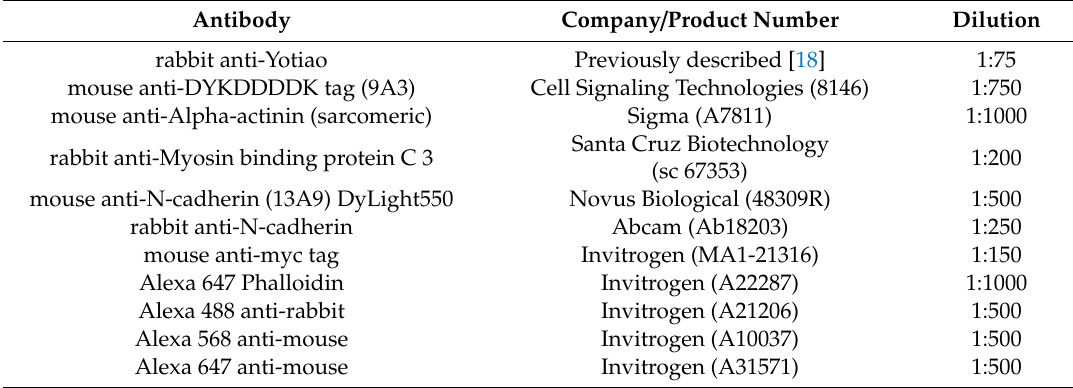
Table 1. Antibody dilutions and product